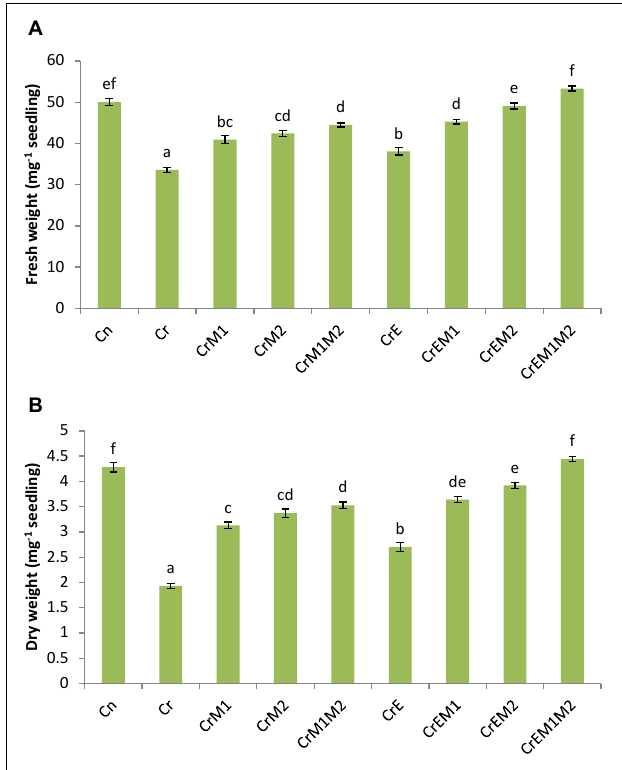
FIGURE 1 | Effect of PGPR [ Pseudomonas aeruginosa (M1) & Burkholderia gladioli (M2)] and the earthworms [ Eisenia fetida (E)] on (A) fresh weight and (B) dryweight of 10-day-old B. juncea seedlings under chromium (Cr) toxicity. Data are presented as means of three independent replicates ± S.E. (standard error). Different letterson the bar graphs indicate that mean values of the treatments are significantly different at p ≤ 0.05 (Tukey’s